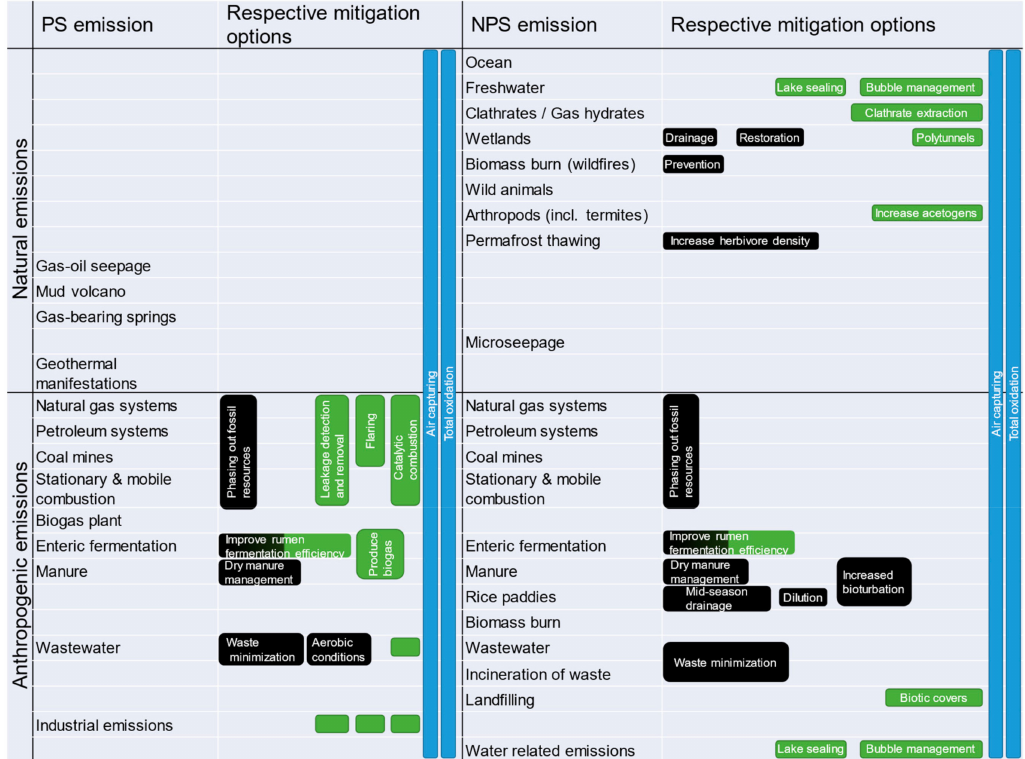
Figure 7. Mitigation options for natural and anthropogenic methane emission sources, categorized by PS and NPS. Black indicates pre-generation mitigation, green indicates in-situ mitigation, and blue indicates post-emission